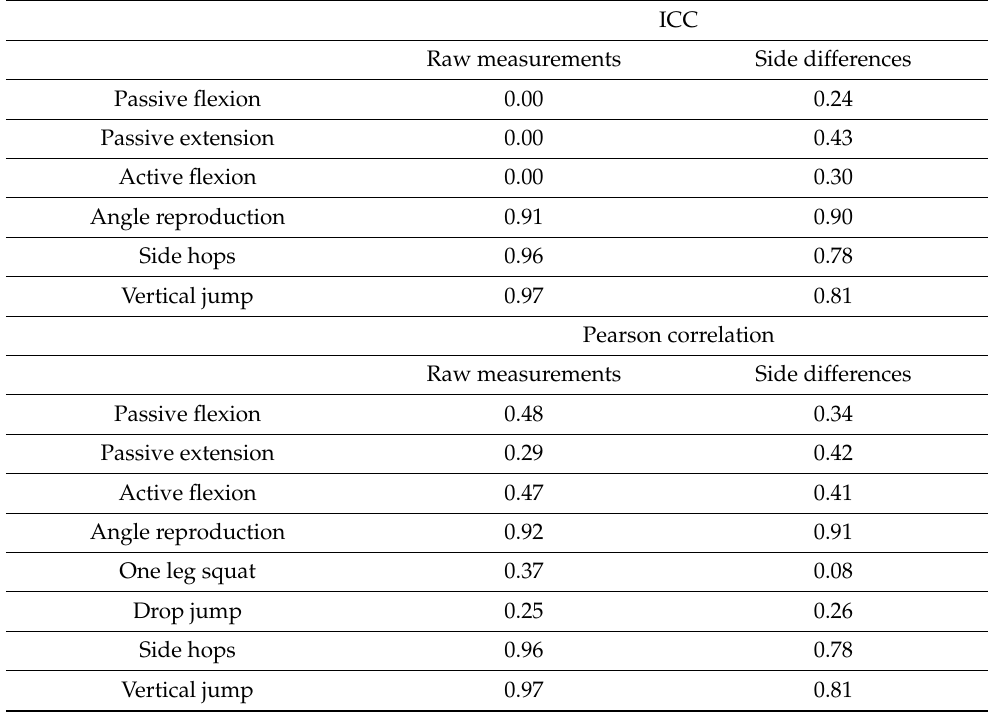
Table 6. Agreement and association of raw measurements and side differences assessed by ICC values and Pearson correlation, respectively.